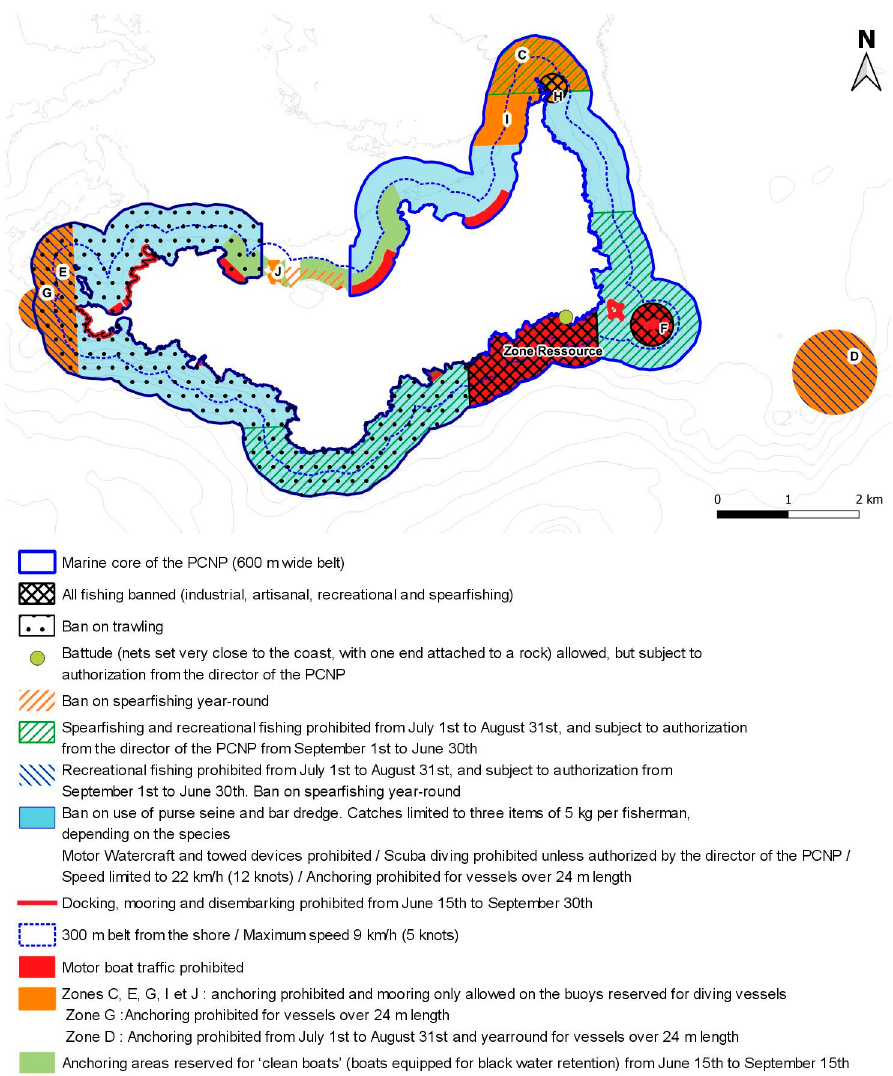
Figure 3. Boating, anchoring, scuba-diving, and artisanal and recreational fishing regulations within different areas (A through H) of the Porquerolles MPA (Port-Cros National Park). Other regulations are not shown on this map. Original drawing © Marie Clap (PCNP).